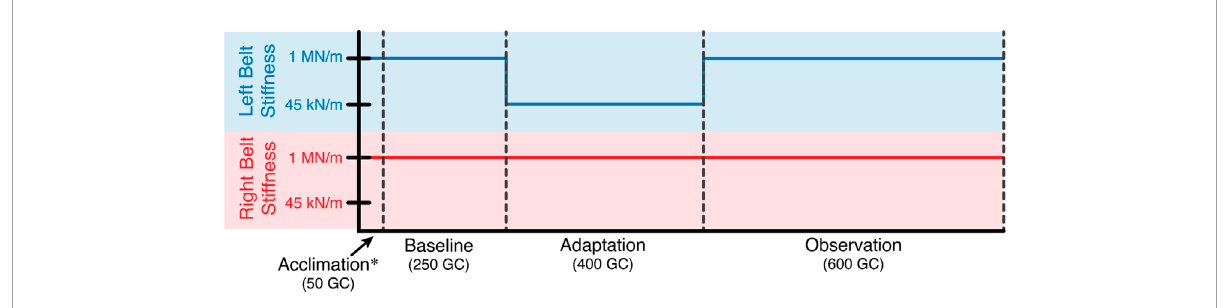
FIGURE 2 Experiment layout in terms of gait cycles. For the entire experiment, the stiffness of the right treadmill belt remained rigid (1 MN/m). The stiffness of the left treadmill belt was reduced to 45 kN/m for the adaptation phase. Otherwise, the left belt stiffness was also